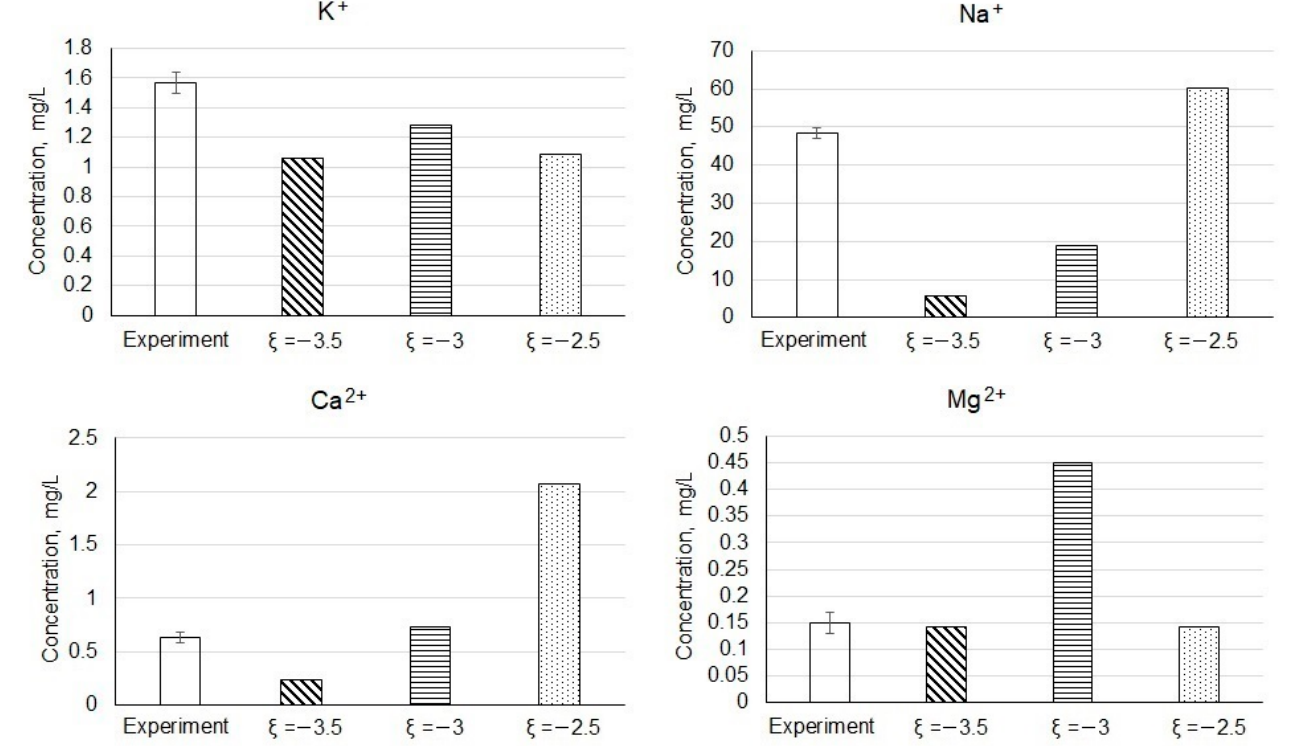
Figure 5. Comparison of the concentrations of the main cations in the resulting solutions obtained in the course of experiments with the simulation data.